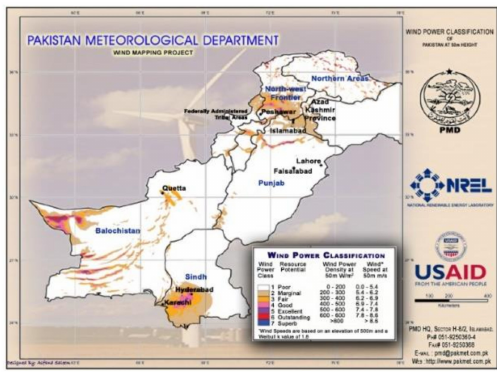
Figure 4. Wind resource map of Pakistan [46].